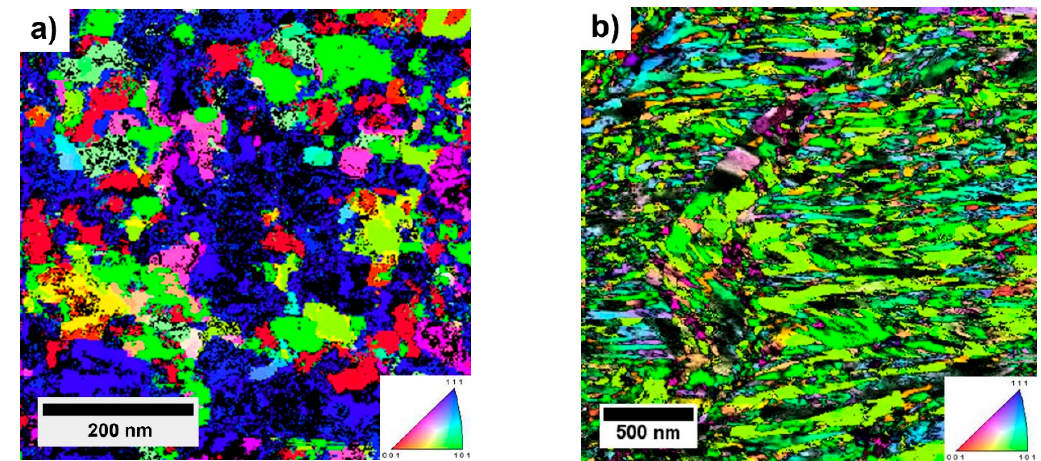
Figure 3. IPF map obtained using ACOM-TEM technique and the corresponding orientation triangle for BCC structure ( a ) HPT, ( b ) RS condition.